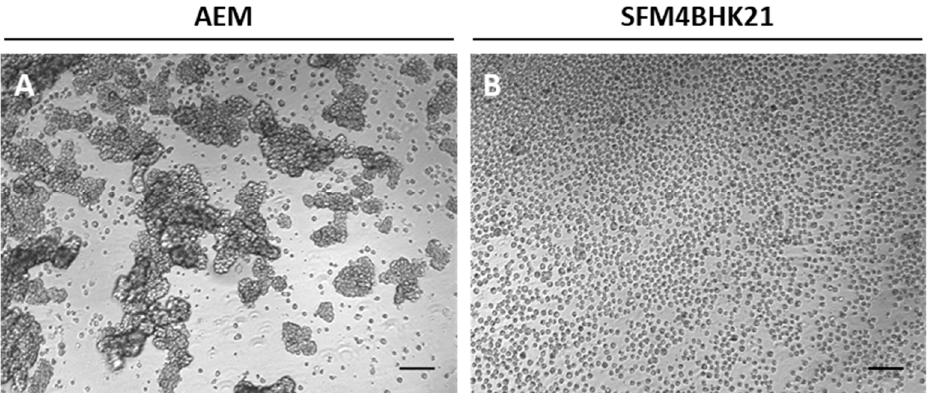
Figure A2. Morphology of MDCK.SUS2 (ECACC) after adaptation to suspension. ( A ) MDCK.SUS2 cells previously adapted to suspension and growing as aggregates in AEM [9], were used as ECACC supplier representative. Direct adaptation of MDCK.SUS2 to SFM4BHK21 medium did not enable cell growth, only the stepwise approach ensured cell survival and resulted in single cell cultures ( B ). Cells were analyzed and digitally visualized as described in Figure 1. Scale bar—100 μ m.